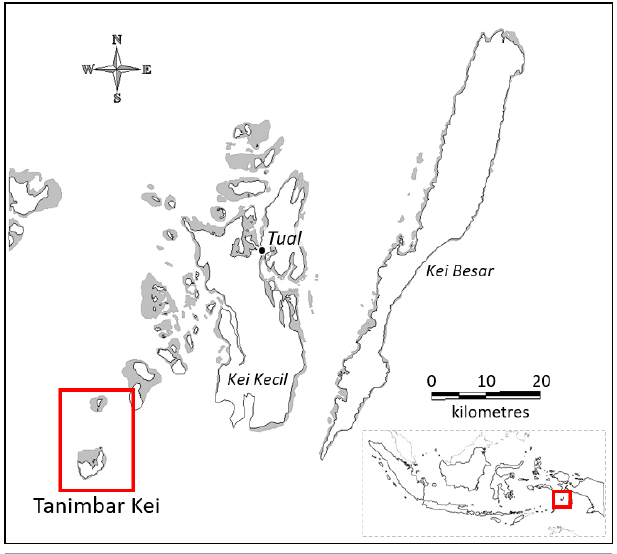
Fig. 1 . Map of the Kei Islands in Southeast Maluku district (Indonesia), indicating the location of Tanimbar Kei as the study site (embedded